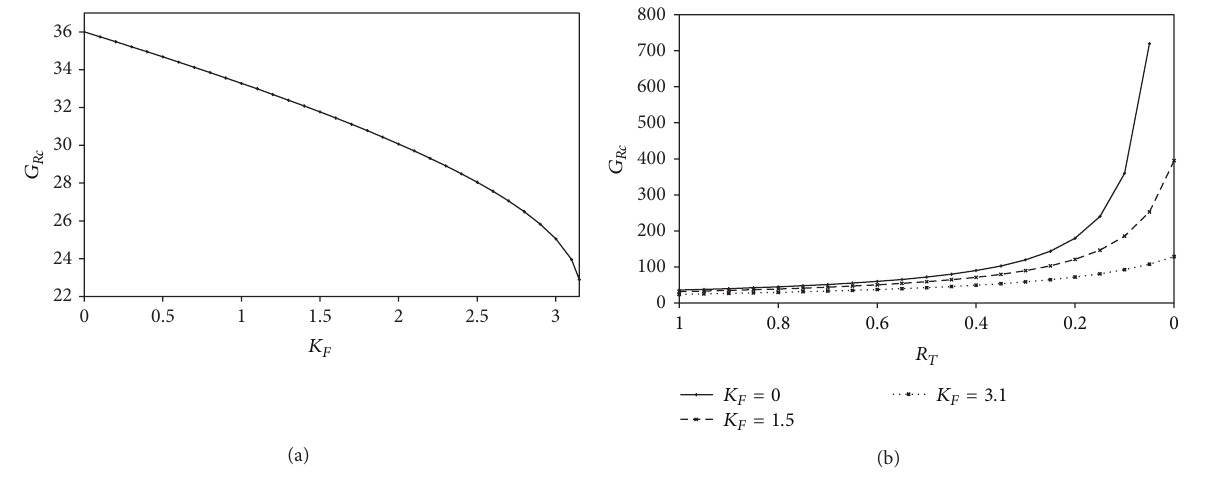
Figure 3: The critical value 𝐺 𝑅𝑐 for the onset of a flow reversal with (a) increasing 𝐾 𝐹 and (b) reducing 𝑅 𝑇